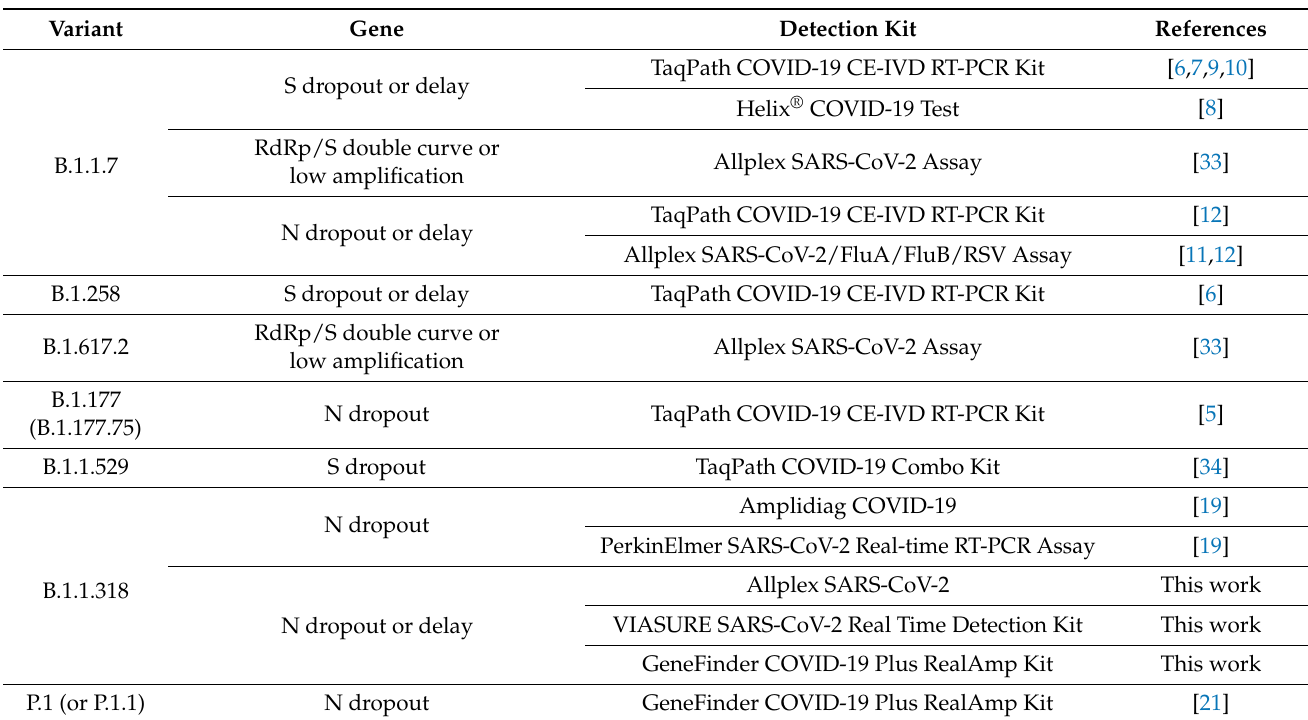
Table 1. List of commercial kits used for presumptive identification of specific SARS-CoV-2 variants based on viral gene amplification delays or